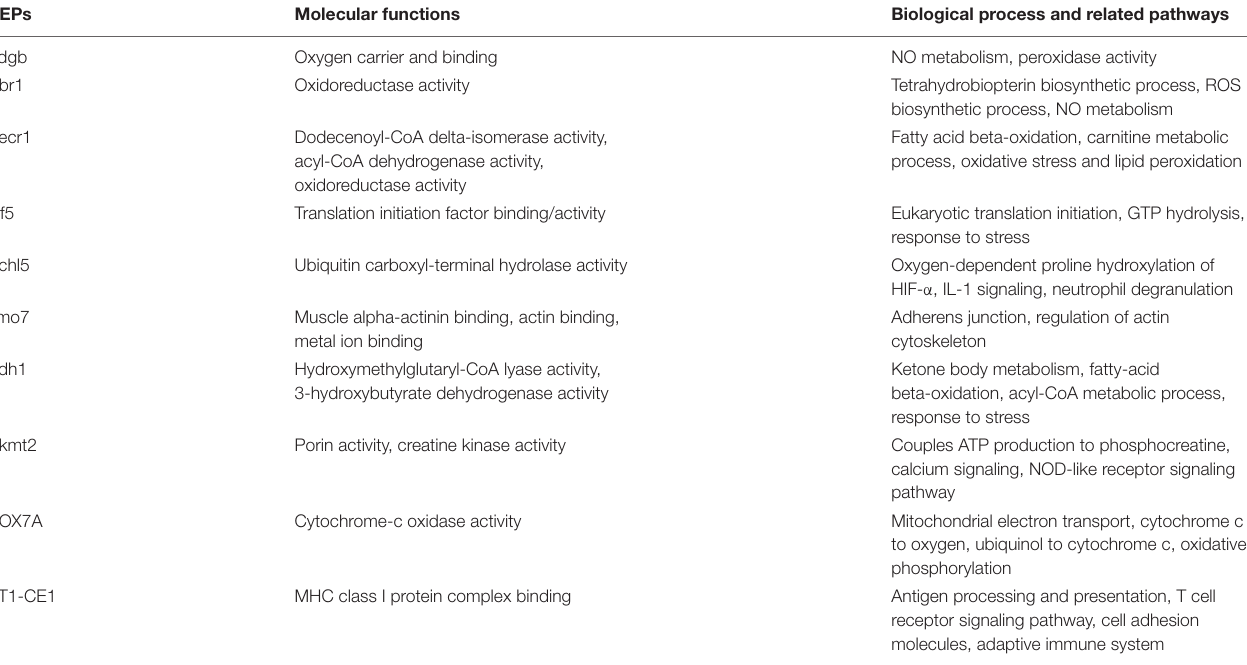
TABLE 3 | Molecular functions, biological processes, and related pathways of the 10 differentially expressed proteins (DEPs) among the three groups of Sham, I/R, and HS + I/R. DEPs Molecular